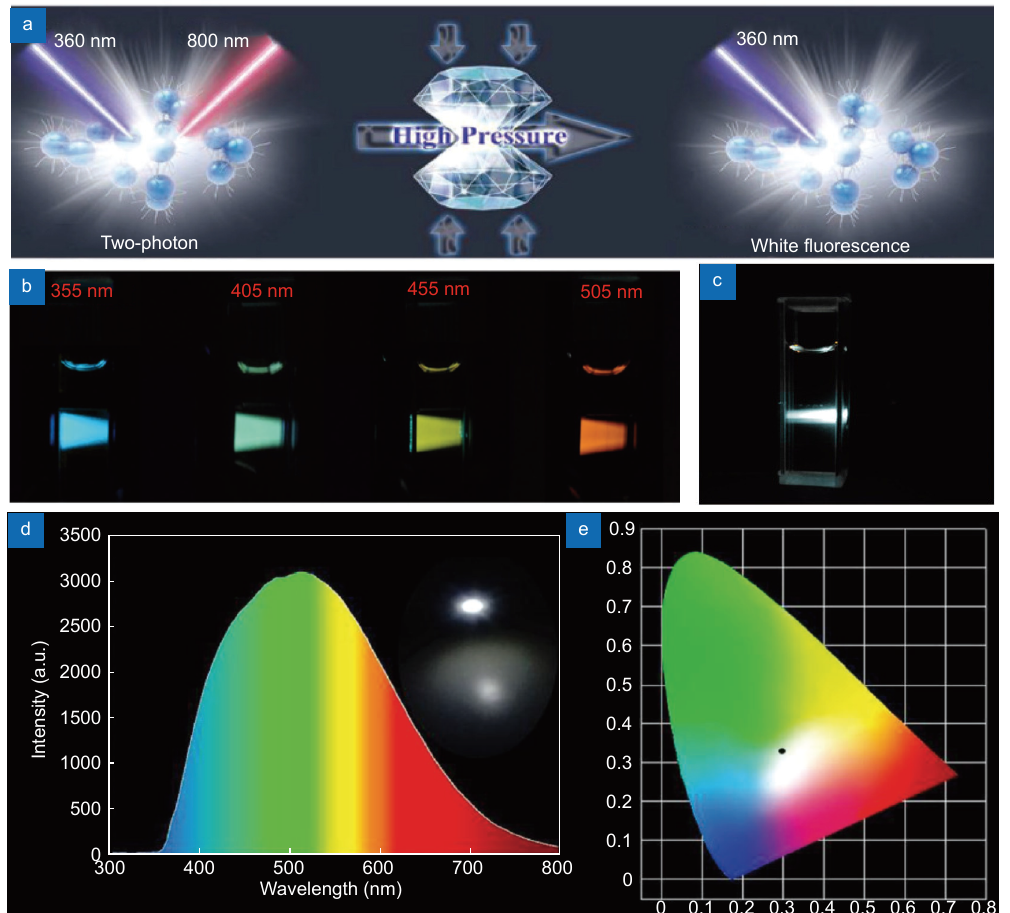
Fig. 9 | ( a ) White emission of Ti 3 C 2 . ( b ) PL color of the V 2 C QDs under different excitation wavelengths. ( c ) V 2 C MQDs colloid under 355 nm pulsed laser pumping. ( d ) Emission spectrum of white LED ( e ) Chromaticity diagram (CIE 1931) coordinates of the white LED (0.30, 0.34). Fig- ures were reproduced with from: (a), (d), (e) ref. 36 . Copyright 2019, WILEY-VCH; (b), (c) ref. 37 . Copyright 2019, John Wiley and